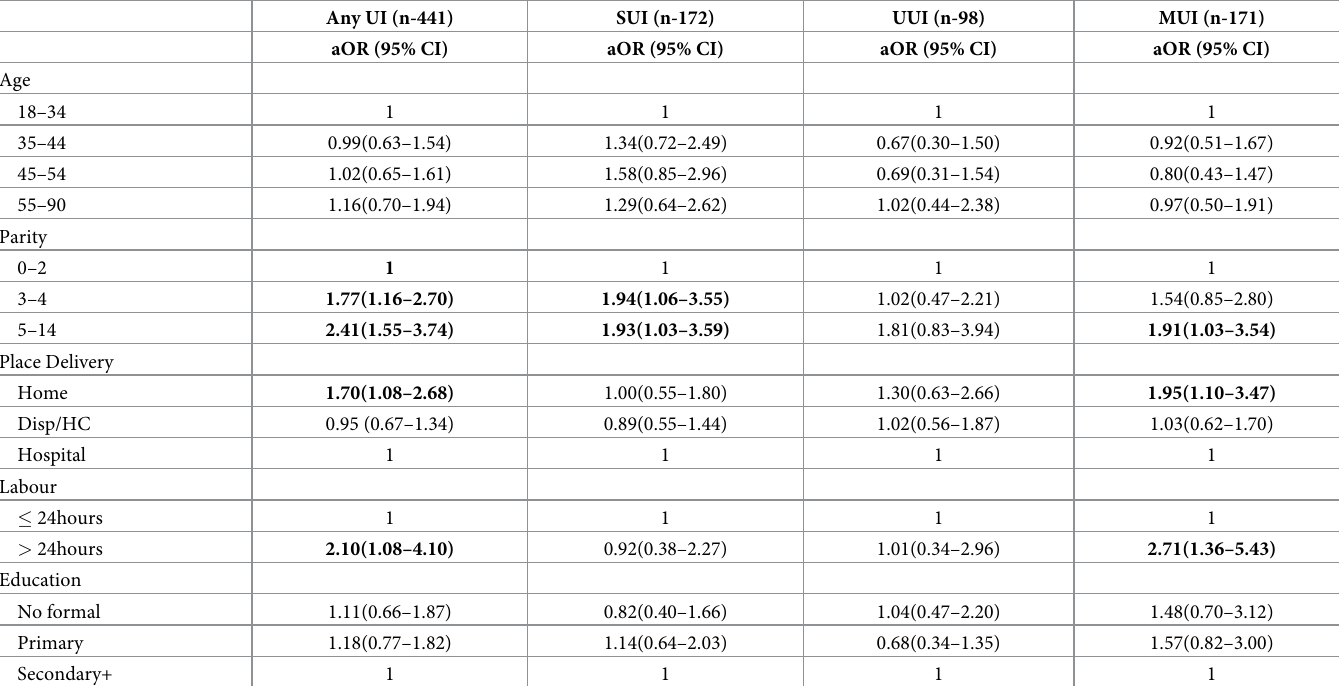
Table 3. Multivariate analysis of risk factors associated with any UI, SUI, UUI and MUI.